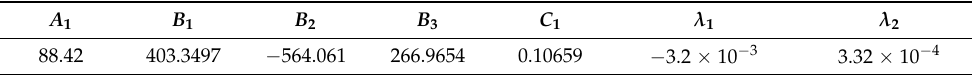
Table 4. Calculated Modified Johnson–Cook model